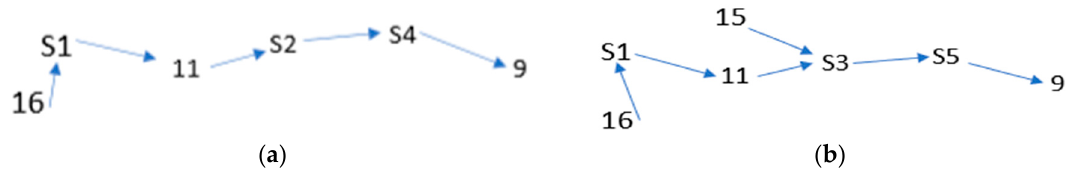
Figure 11. ( a ) Disassembly order graph (DOG) Seq. 1; ( b ) DOG Seq.